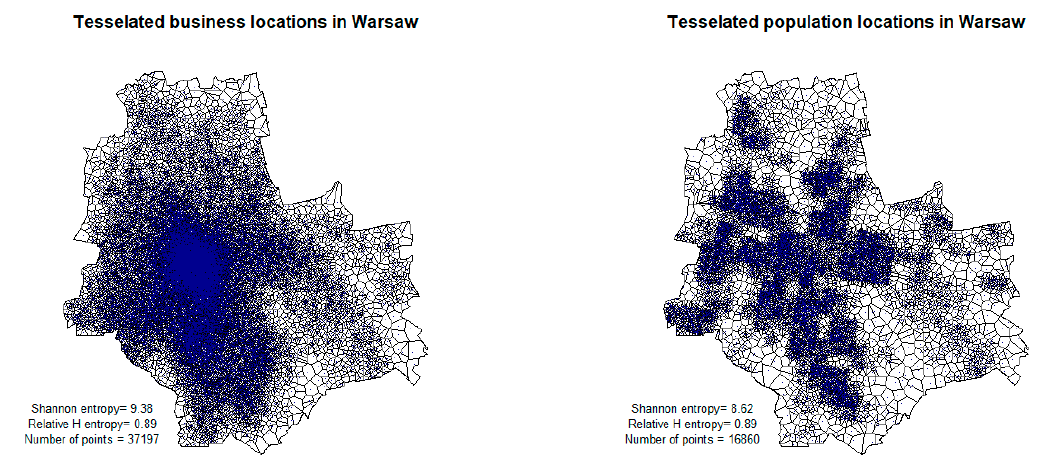
Figure 4. Tessellated business and population locations in the urban area of Warsaw to assess the degree of